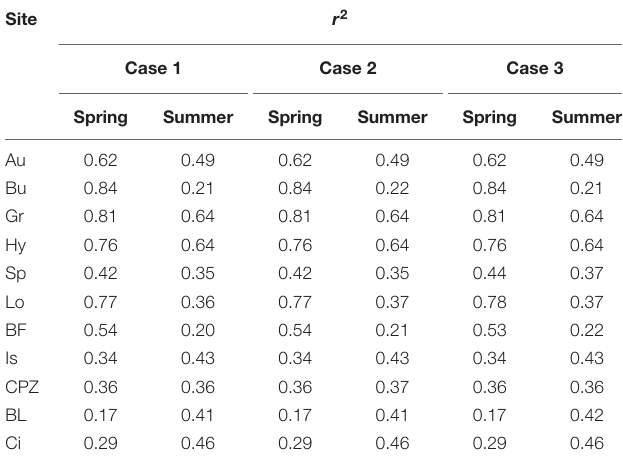
TABLE 4 | r 2 derived from MLR modeling of NEP calculated separately for Spring and Summer from three combination of independent variables: Case 1: